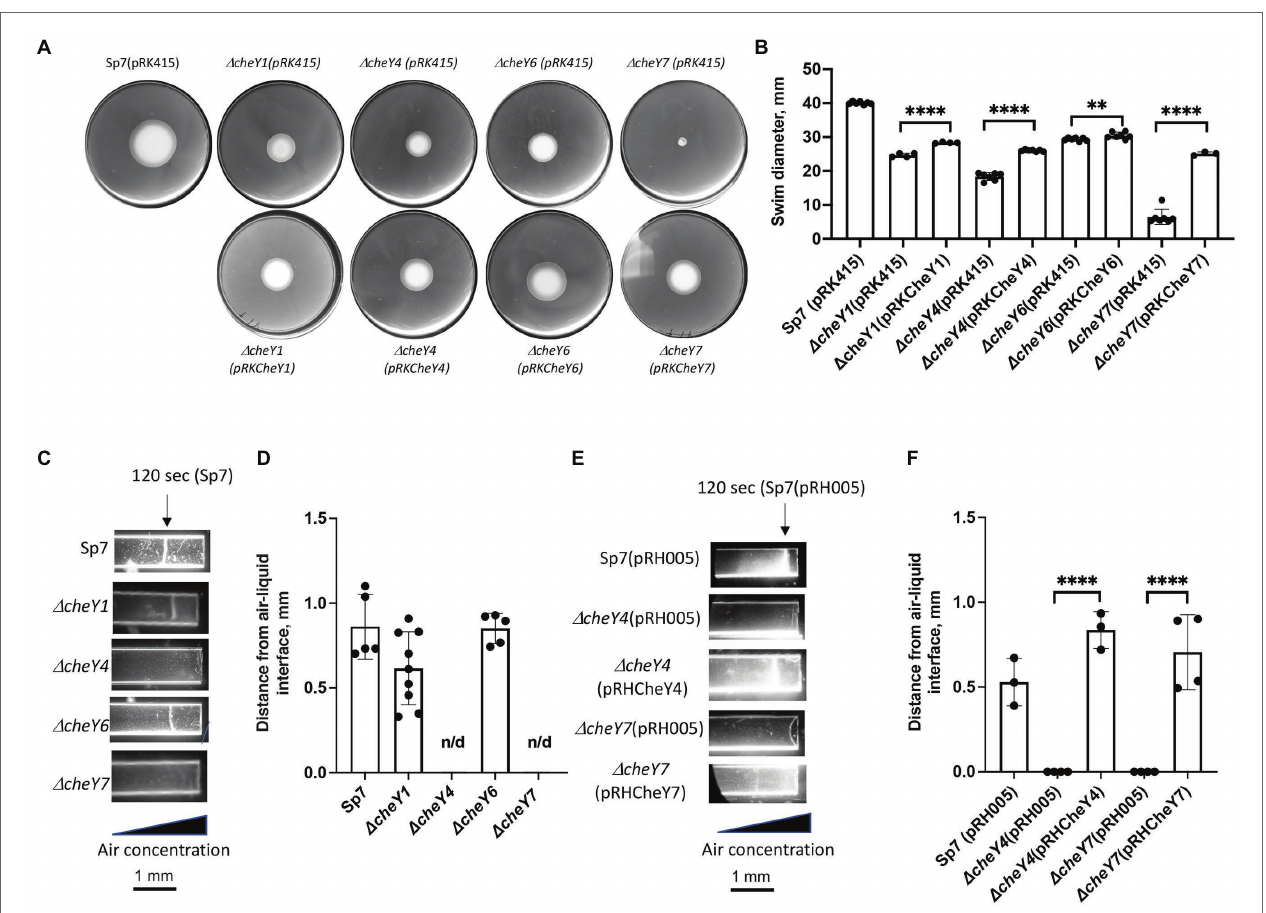
FIGURE 2 | Detection and quantification of chemotaxis (A,B) and aerotaxis (C-F) responses in the A. brasilense and Δ cheY mutant derivatives. (A) Chemotaxis in the soft agar plate assay. (B) Quantification of chemotaxis in the soft-agar plate assay. (C) Aerotaxis in the spatial gradient capillary assay. The air gradient is established by diffusion into capillary tubes filled with a suspension of motile cells. The triangle represents decreasing air concentration as a result of diffusion within the cell suspension. The images were taken 120 s after placement of the cells into the capillary tubes. (D) Quantitation of the aerotaxis response represented as the distance from the edge of the air-liquid interface. (E) Aerotaxis of Sp7 (pRH005), ΔcheY4 (pRH005), ΔcheY7 (pRH005), and mutants complemented with CheY4-YFP, expressed as pRHCheY4 (for ΔcheY4 ) and CheY7-YFP, expressed as pRHCheY7 (for ΔcheY7 ) in the spatial gradient assay for aerotaxis. (F) Quantitation of the aerotaxis response in Sp7(pRH005), ΔcheY4 (pRH005), ΔcheY7 (pRH005), and mutants complemented with CheY4-YFP, expressed as pRHCheY4 (for ΔcheY4 ) and CheY7-YFP, expressed as pRHCheY7 (for ΔcheY7 ) in the spatial gradient assay represented as the distance from the edge of the air-liquid interface. ** p < 0.01 and **** p <